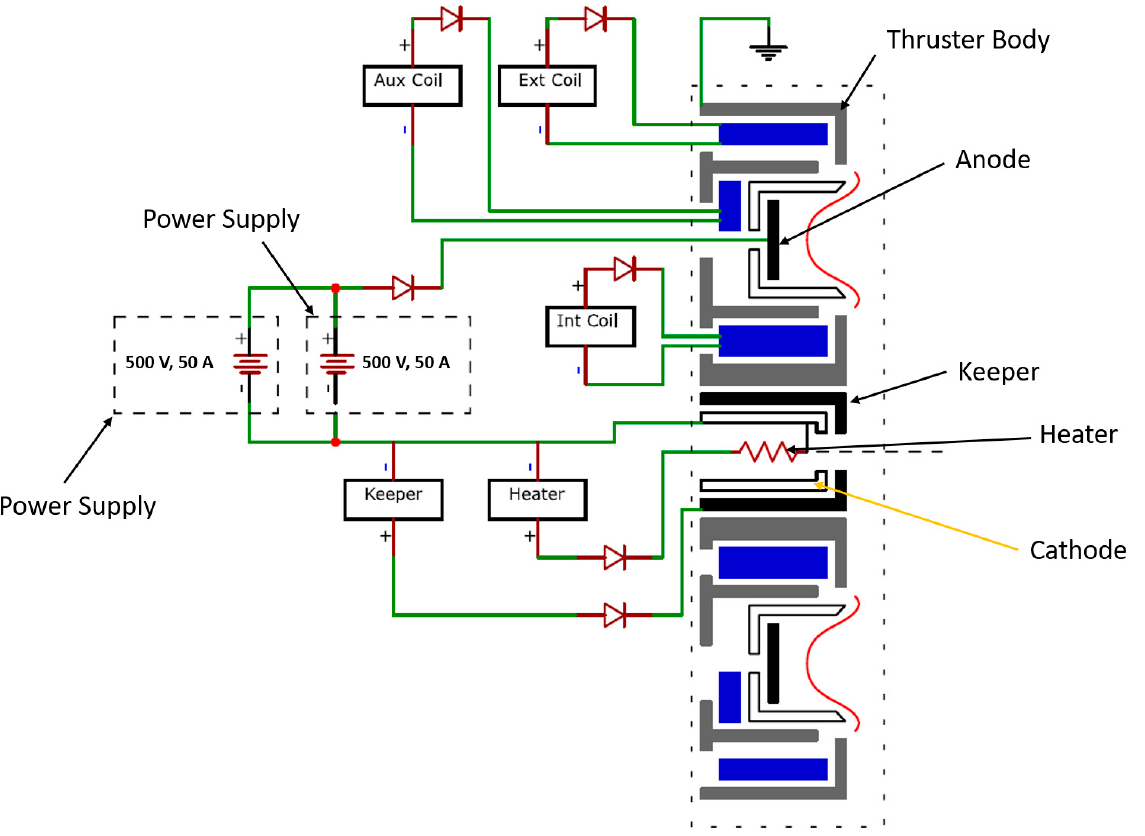
Figure 3. Electrical scheme—the thruster body was grounded. Two separate laboratory mass flow controllers were used to provide the required xenon flow rate, the Bronkhorst F-201CV-500-AAD-88V for the anode and the Bronkhorst F-201C-FAC-88-V for the cathode, with an accuracy of 0.5% with respect to the set value. The generated thrust was measured using a single axis thrust stand with a double pendulum configuration. The sensing element was based on high precision load cells measuring the strain on the flexural elements. The thrust stand was mounted on a tilting platform actuated by a stepper motor. This system allowed us to level the thrust stand during calibration. The thrust stand was also equipped with an electromagnetic calibrator, generating a reference force when requested. The calibrator was specifically built for the thrust stand; it is thermoregulated and has an accuracy in the order of 2‰ (2 parts per thousand). The calibration was performed at least twice a day, in cold and hot conditions for the thruster. The thrust measurement accuracy using this stand is ± 10 mN. The thrust stand was also used during the test of the HT5k thruster, and there were no significant differences between the measured vales of thrust obtained in the same operating conditions with a different thrust stand